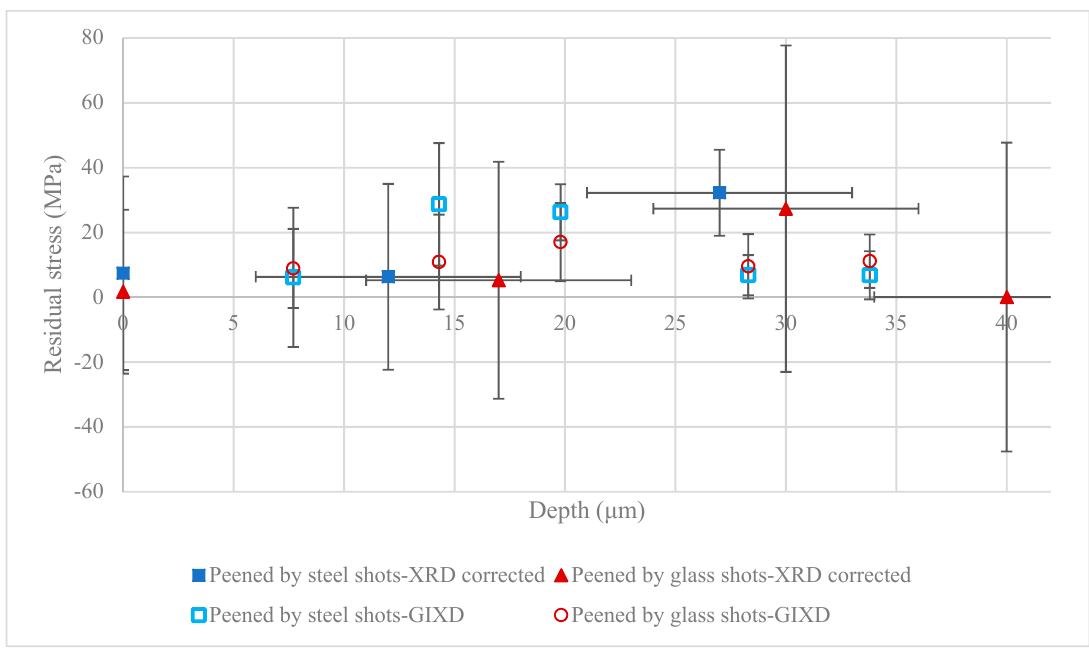
Figure 9. Results of the grazing-incidence X-ray diffraction (GIXD) method on the shot peened sample using steel and glass shots, and comparison with corrected stress evaluated by XRD.